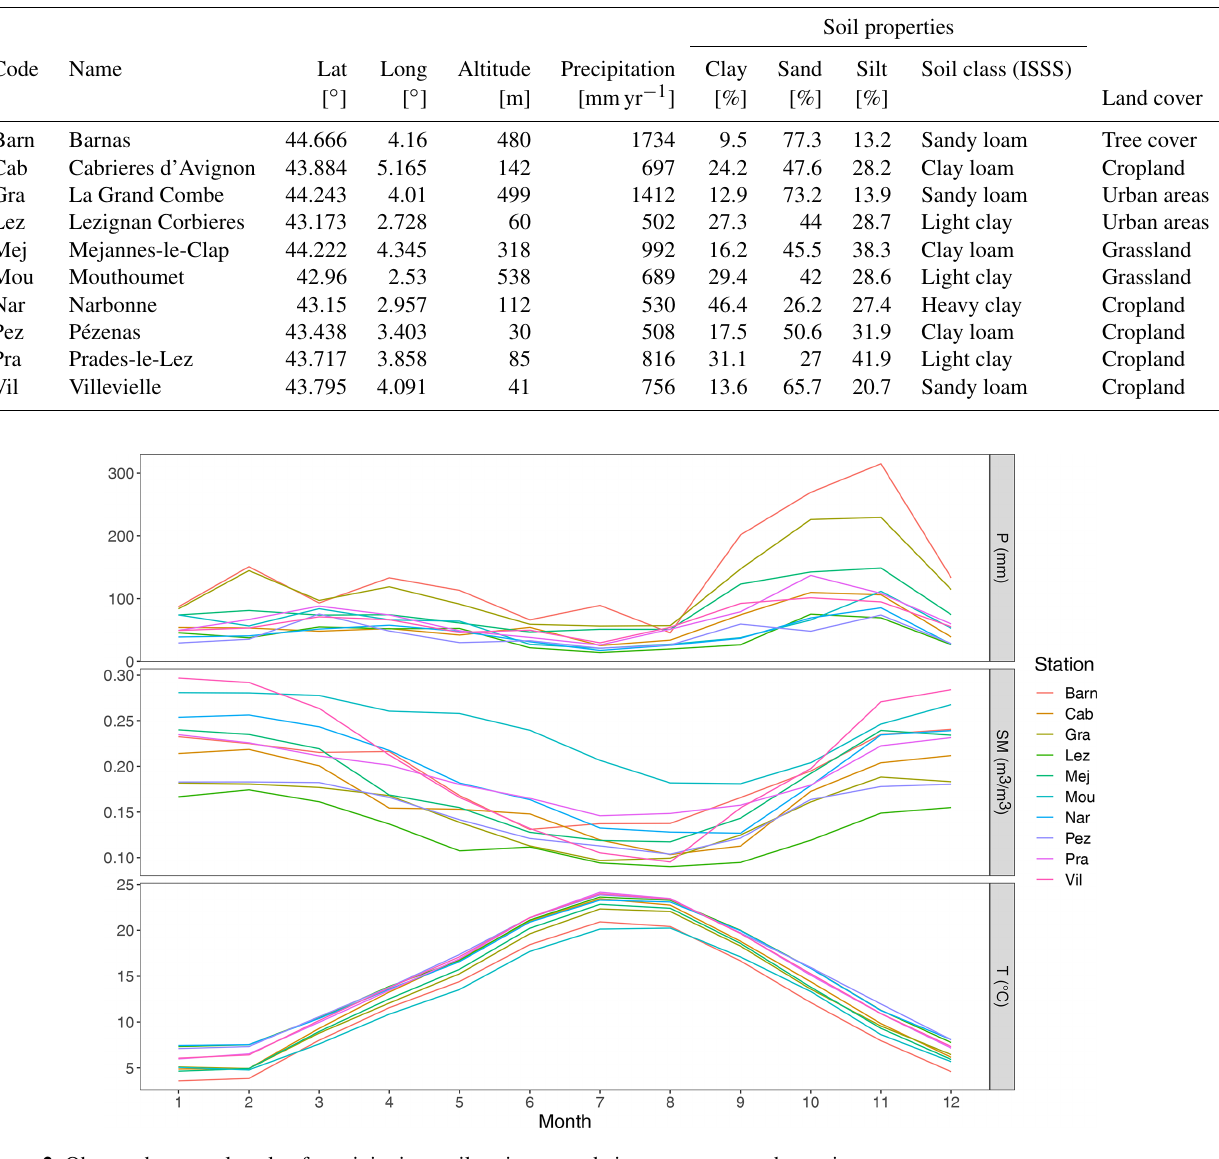
coefficient for evapotranspiration K c (calibration ranges in